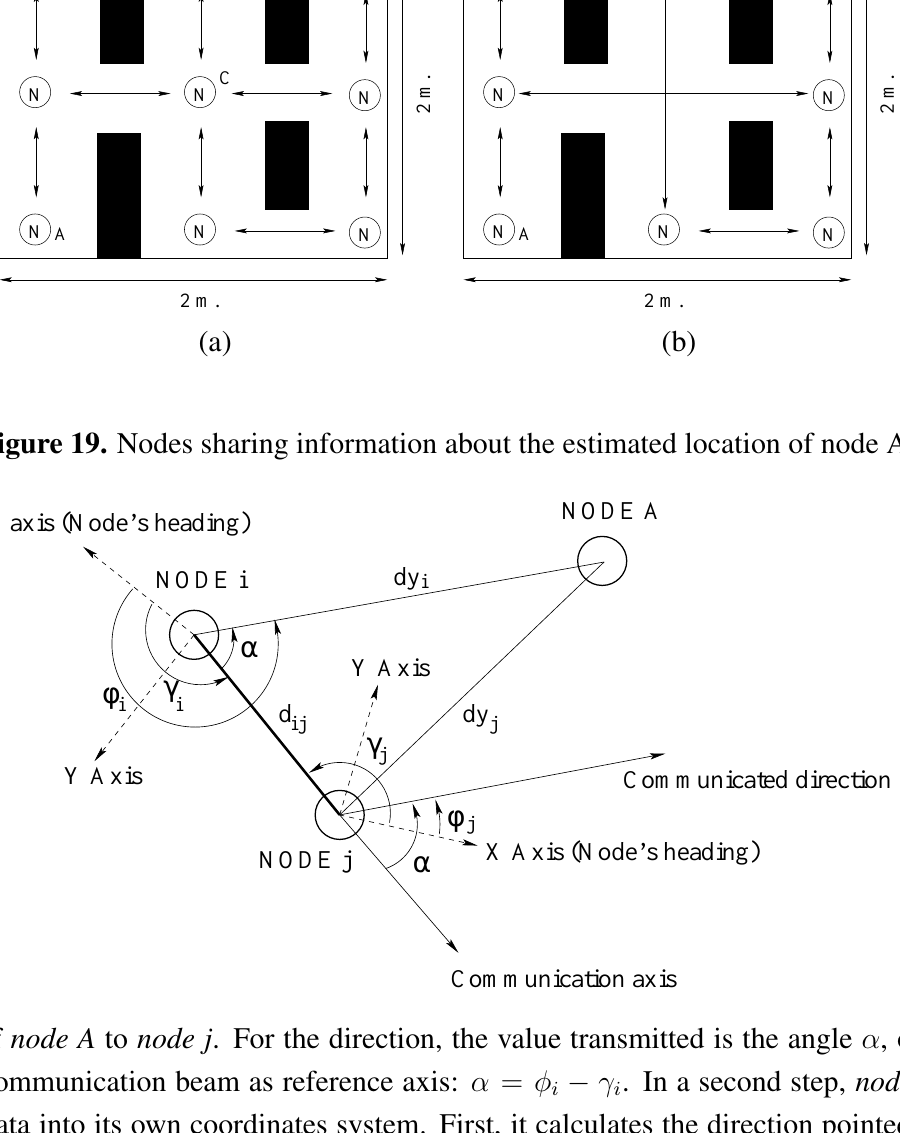
Figure 18. (a) Physical arrangement of a multi-node network on an environment with obsta- cles experiment. (b) Physical arrangement of the network when node C has been removed. Communication axis are represented by a black double arrow.